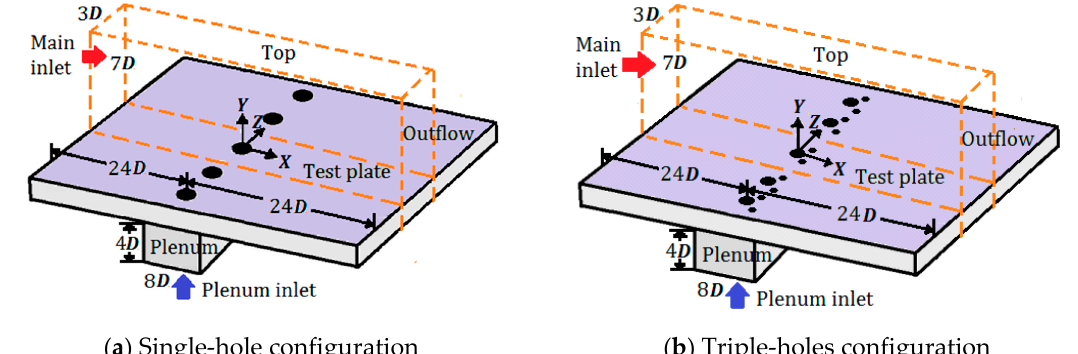
Figure 1. Computational domains of the single- and triple-hole configurations (orange dashed lines).